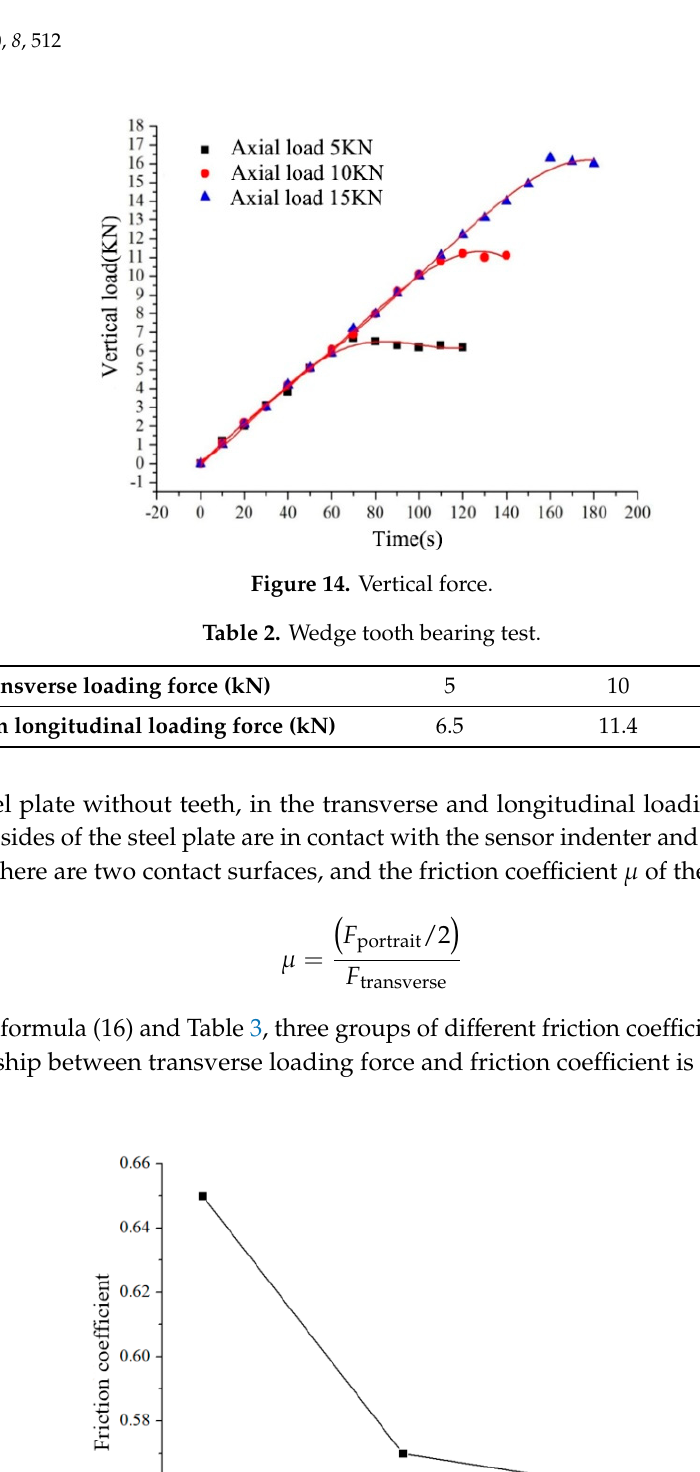
Figure 15. Relationship between friction coefficient and transverse load.